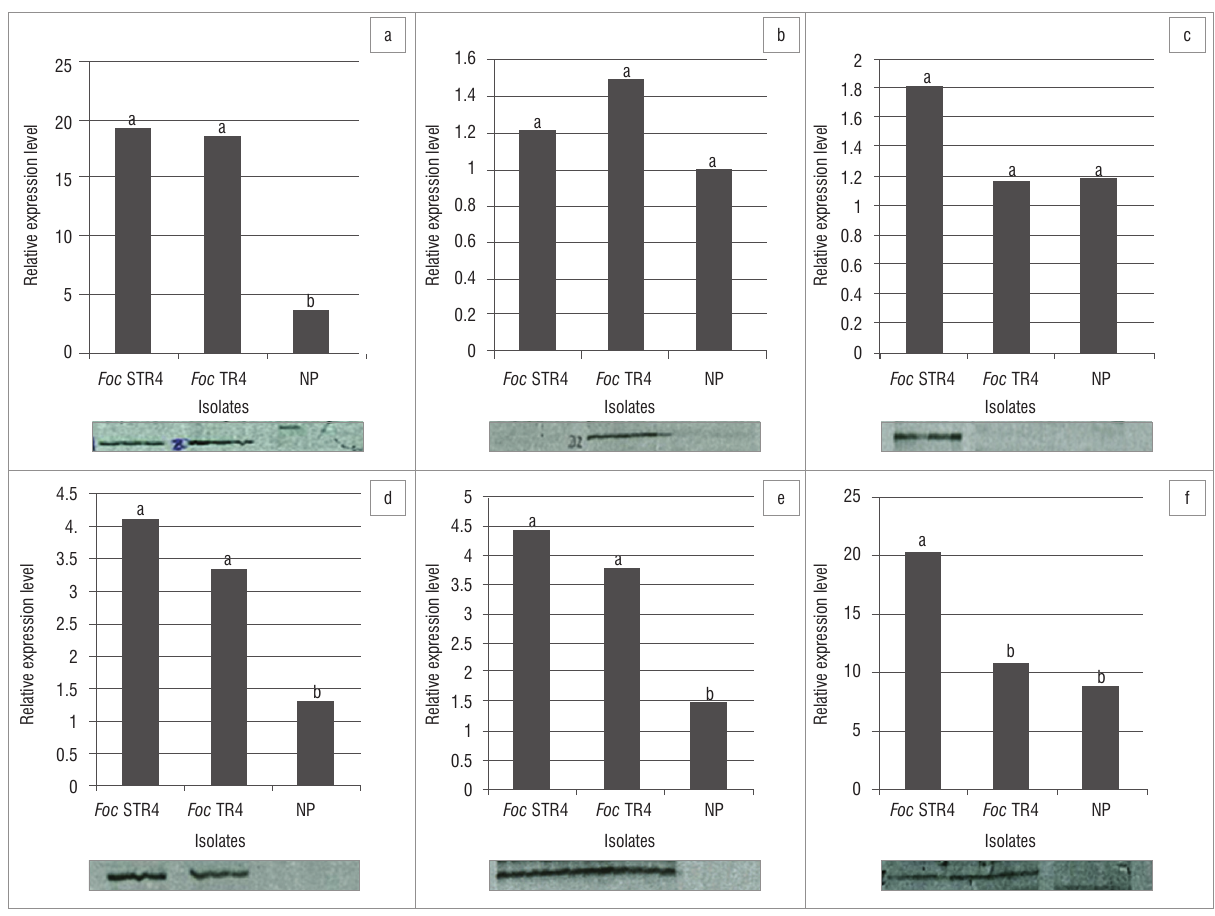
Verification of the relative expression of selected genes by quantitative real-time PCR in Fusarium oxysporum f. sp. cubense ( Foc ) sub-tropical race 4 (STR4), Foc tropical race 4 (TR4) and non-pathogenic F. oxysporum (NP): (a) MFS multidrug transporter (TDF9), (b)